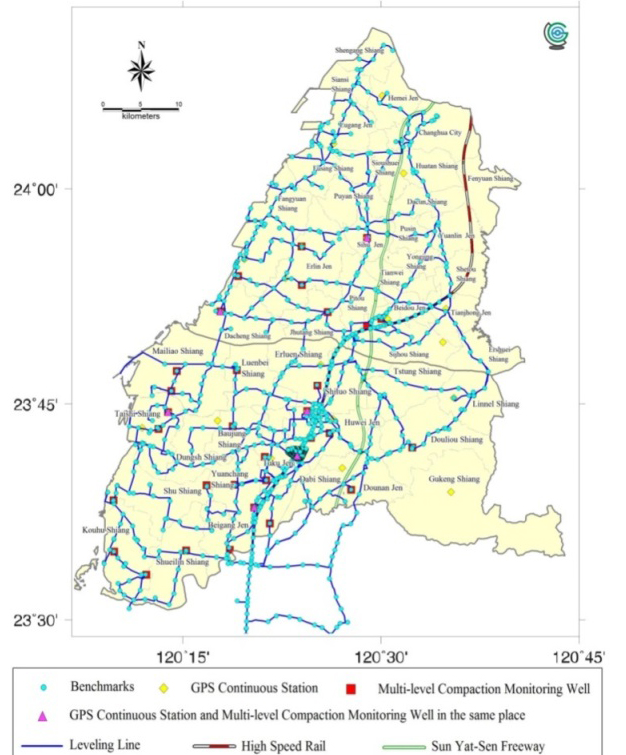
Figure 4. Distributions of leveling benchmarks, monitoring wells and GPS stations in CRAF, the names of townships in Yunlin County and Changhua County are shown